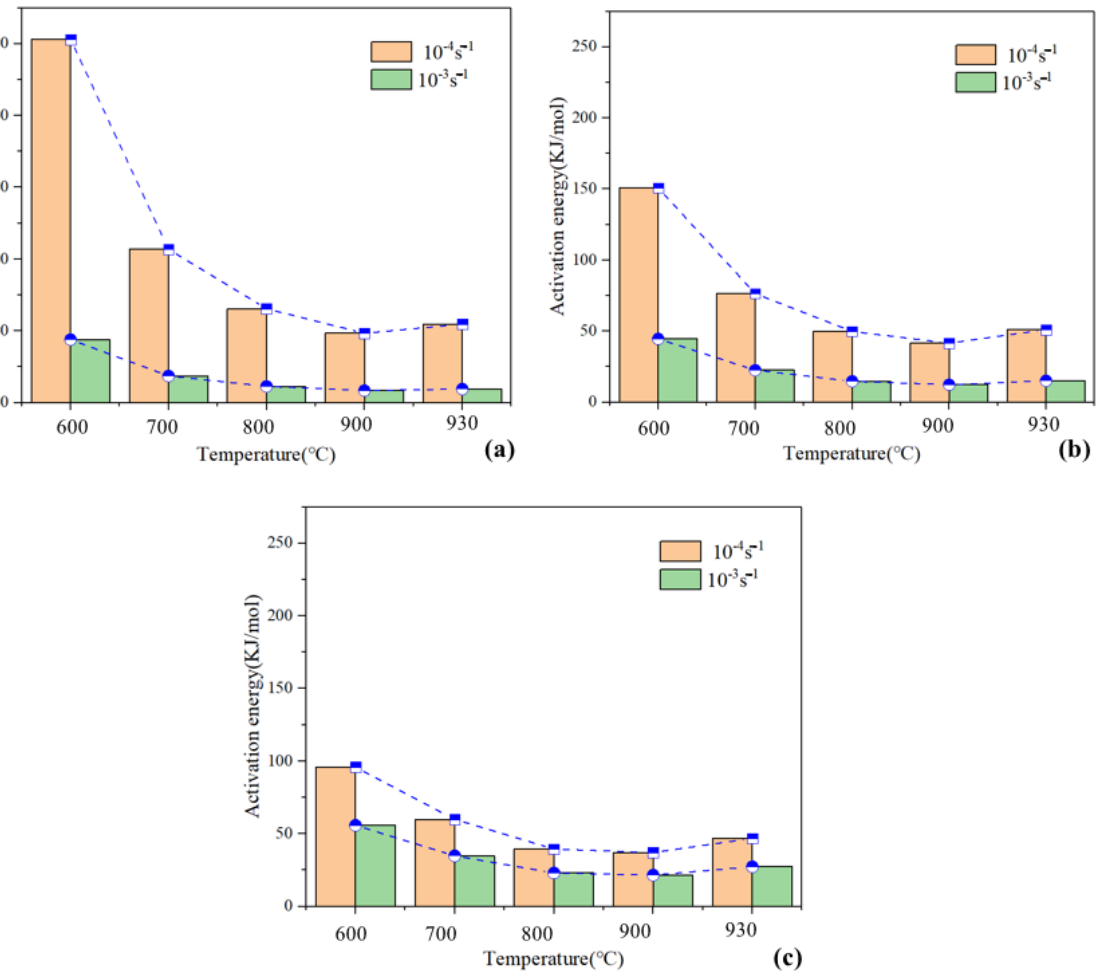
Figure 5. The activation energy for Ti-6Al-4V alloy during the sir cooling after superplastic forming: ( a ) 0.1; ( b ) 0.2; and ( c ) 0.3. ( a ) 0.1; ( b ) 0.2; and ( c )